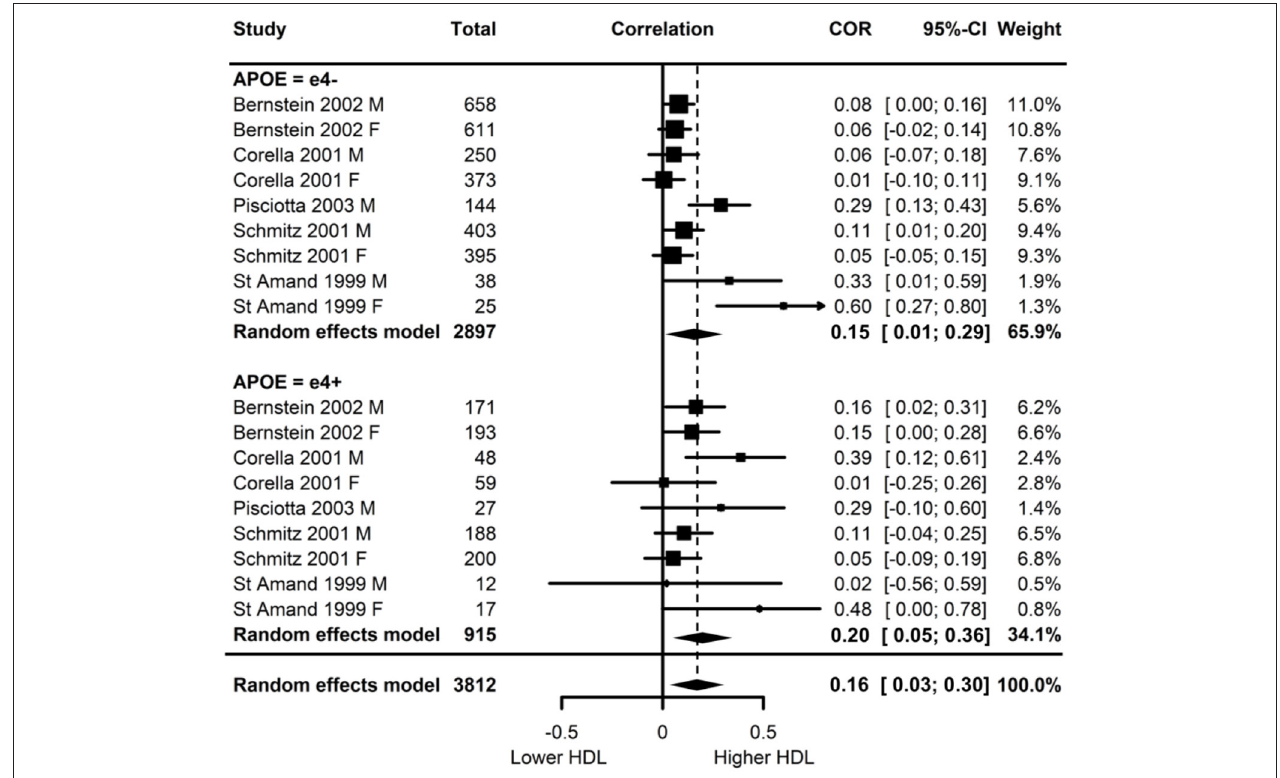
FIGURE 3 | Forest plot indicating the association between physical activity and HDL with carrier (e4 + ) and non-carrier (e4–) subgroups. Subgroup moderation test indicated no significant difference between APOE groups ( p = 0.10).